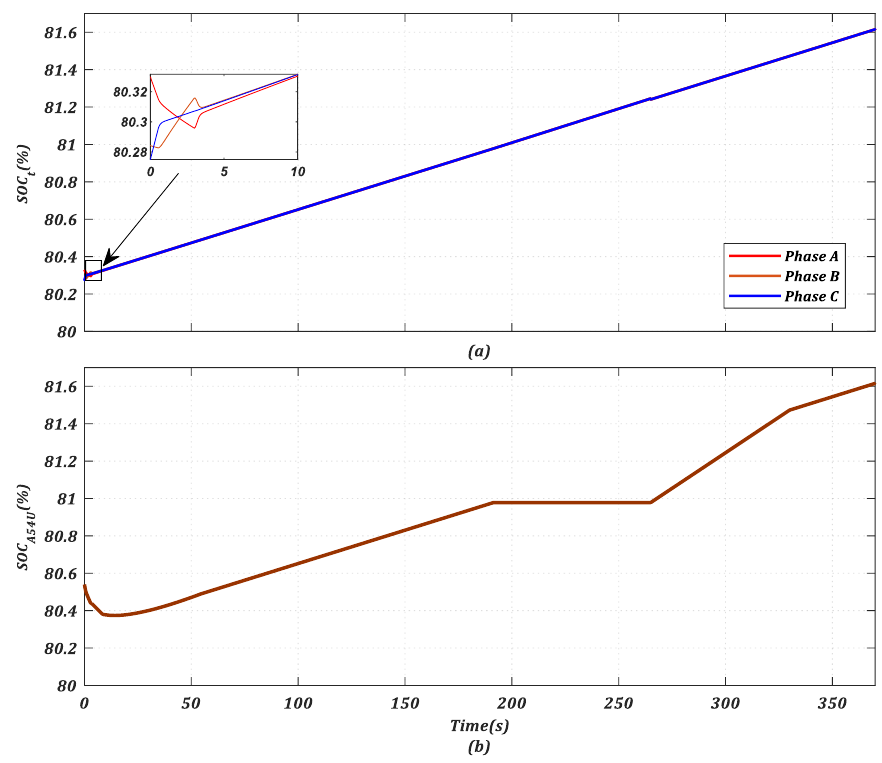
Figure 10. ( a ) Average SOC of the converter legs (phases); ( b ) SOC of battery 54 in phase A upper arm.